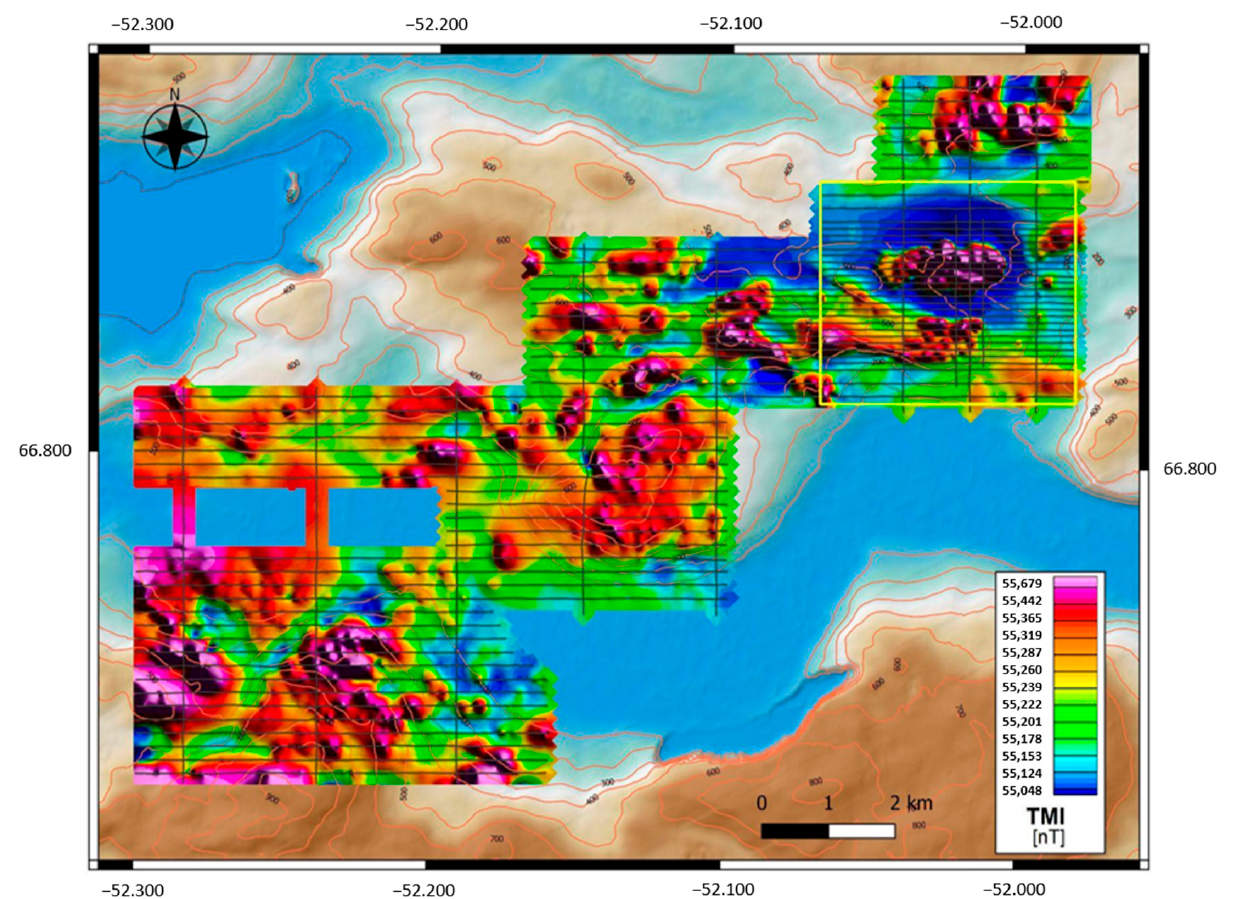
Figure 5. Total magnetic intensity map of the aeromagnetic survey. The black lines indicate the flight lines. The yellow rectangle outlines the area around a mafic intrusion considered in magnetic and hyperspectral data integration.